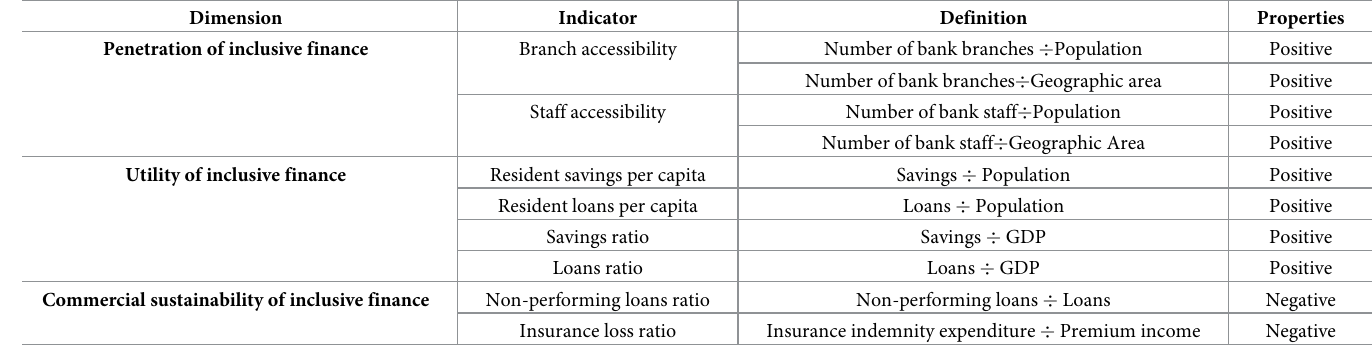
Table 1. Inclusive finance indicator